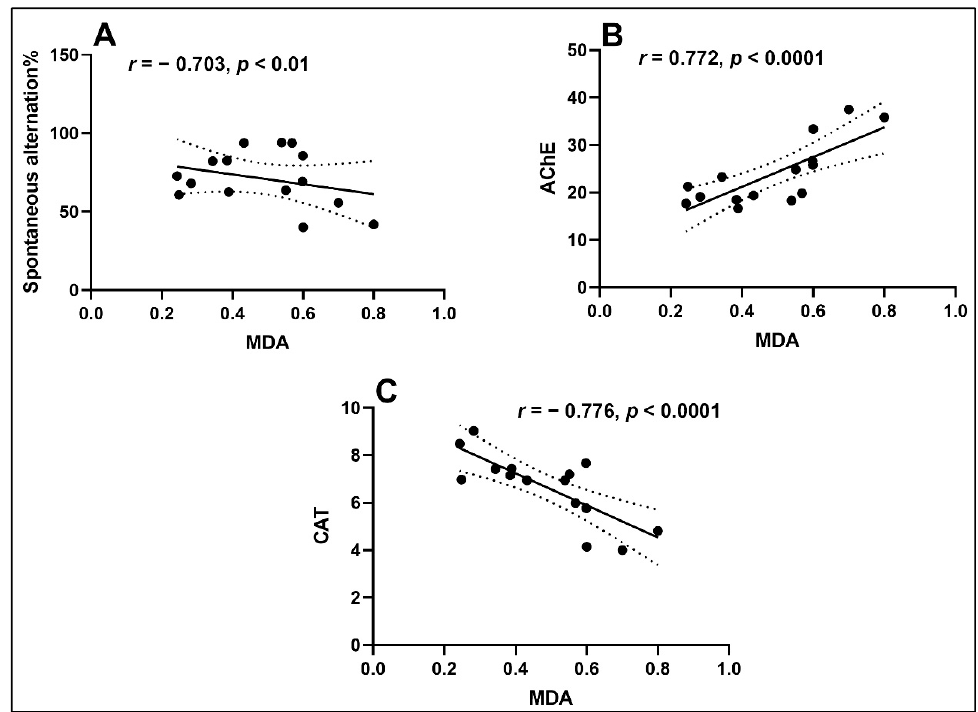
Figure 6. Statistical Pearson’s correlation analyses of behavioral scores and oxidative stress markers ( n = 5). Values expressed are spontaneous alternation%, AChE (nmol/min/mg protein), CAT (U/mg protein), and MDA (nmol/mg protein). ( A ) Spontaneous alternation% vs. MDA ( n = 5, r = − 0.703, p < 0.01); ( B ) AChE vs. MDA ( n = 5, r = 0.772, p < 0.0001); ( C ) CAT vs. MDA ( n = 5, r = − 0.776, p < 0.0001).